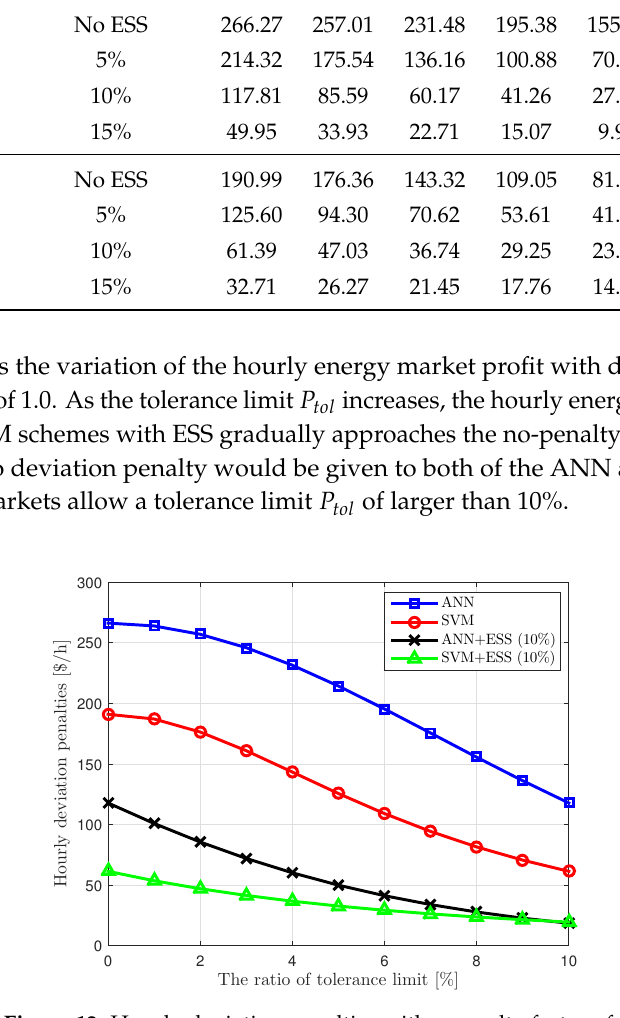
Figure 12. Hourly deviation penalties with a penalty factor of